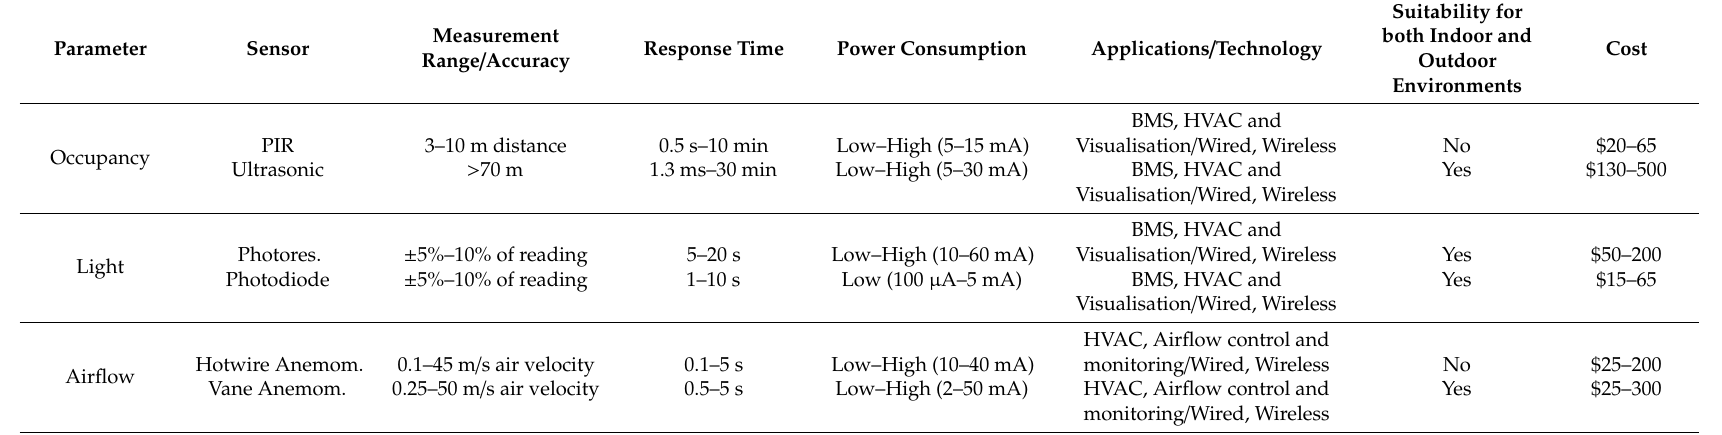
Table 2. Comparison of the key characteristics of airflow, light, and motion detection sensors used in buildings. Data has been extracted or calculated from published literature, and various manufacturer datasheets and user manuals are available online at the time of